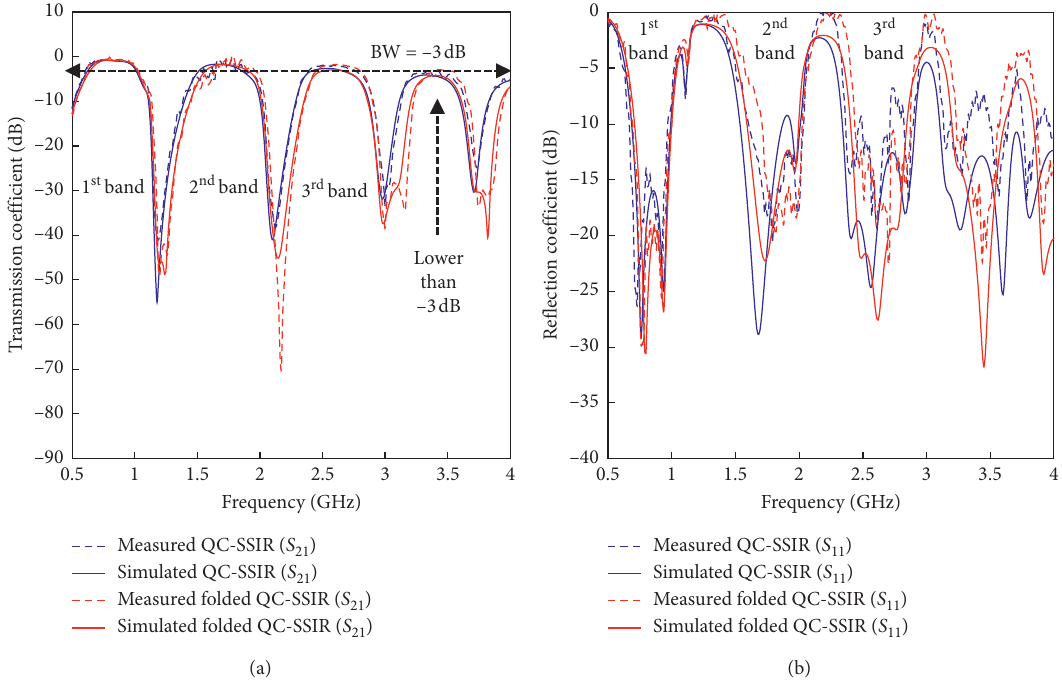
Figure 13: Comparison between the simulated and measured results of the MW-BPF using a QC-SSIR and FQC-SSIR in terms of the (a) transmission coefficients ( S 21 ) and (b) reflection coefficients ( S 11